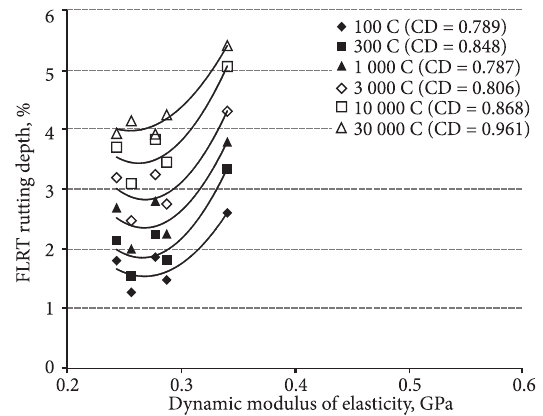
Fig. 6. Good to excellent relationships between dynamic modulus and FLRT rutting depth ( f = 0.1 Hz, T = +46.1 o C)